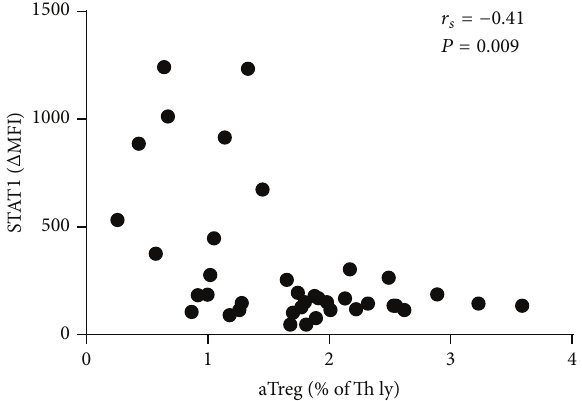
Figure 3: Correlation between STAT1 expression in Th lymphocytes and percentage of aTreg in group containing children and adults. A significant negative correlation was found between STAT1 protein expression in Th lymphocytes and the percentage of aTreg lympho- cytes ( 𝑛 = 40 ). Each symbol represents a single sample. A value of < 0.05 was considered